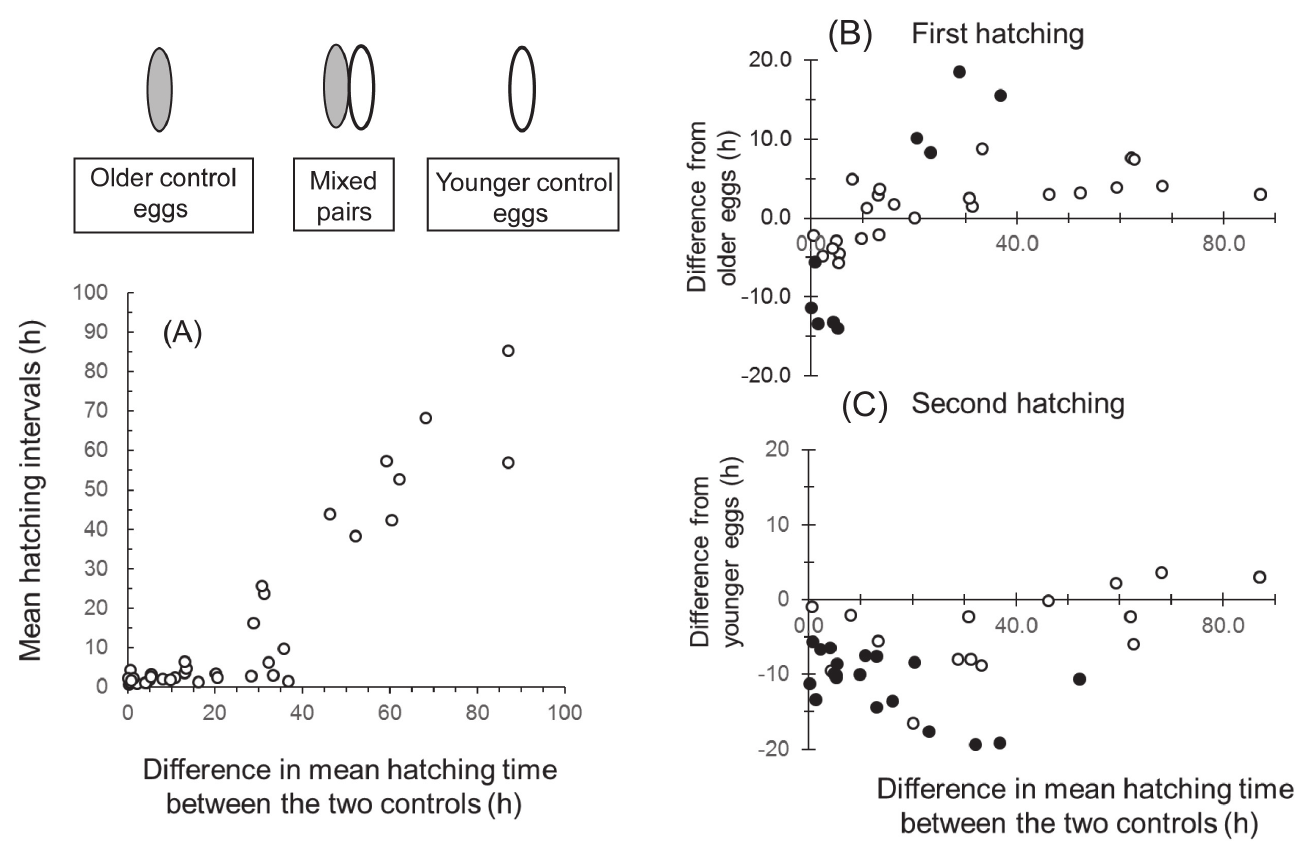
Fig. 14. The effects of pairing of Locusta migratoria eggs at different ages on hatching time. A . The mean hatching intervals between the first and second hatching eggs of the mixed pairs are plotted against the differences in mean hatching time between the younger and older controls in which two eggs were kept singly. B . The differences in hatching time between the first hatching eggs of the mixed pairs and older control eggs (from early-produced pods) are plotted against the difference in hatching time between the two control eggs. C . The differences in hatching time between the second hatching eggs of the mixed pairs and younger control eggs (from late-produced pods) are plotted against the difference in hatching time between the two controls. The diagrams on the top show combinations of eggs from older eggs (gray) and younger eggs (white). A total of 38 pairs of pods were used. Closed circles in ( B ) and ( C ) indicate the means significantly different from the controls (p < 0.05; Tukey’s multiple